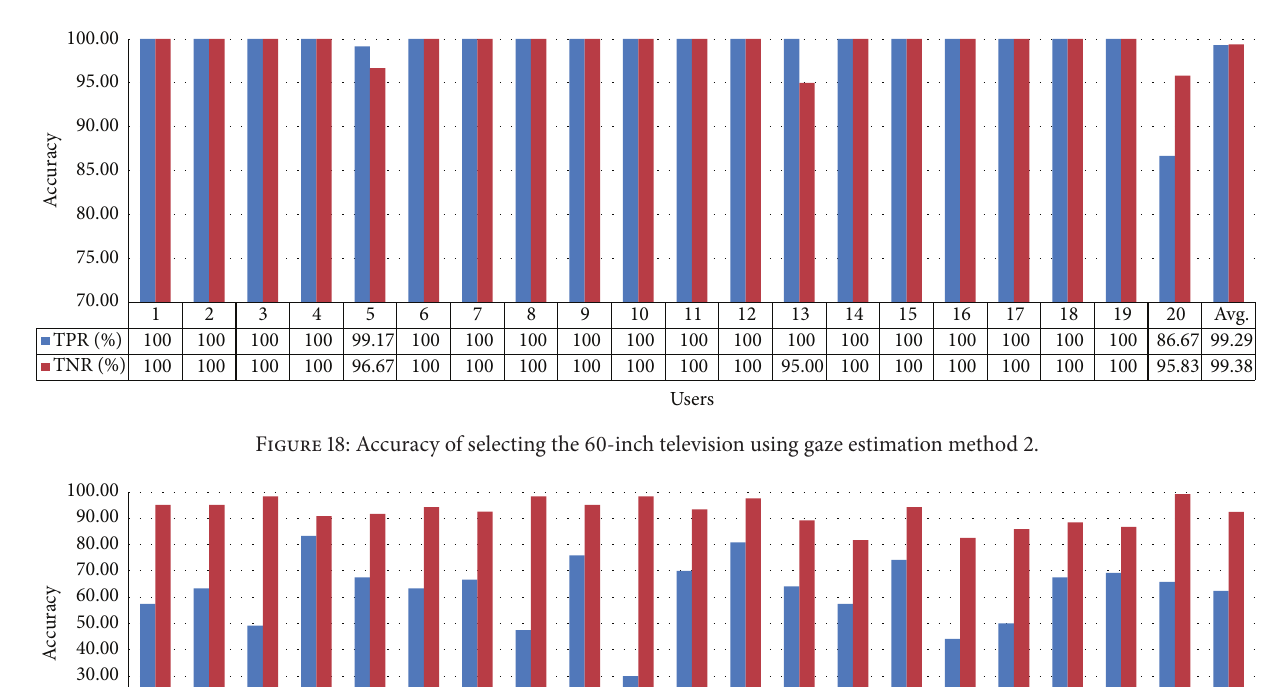
Figure 17: Accuracy of selecting the 60-inch television using gaze estimation method 1.